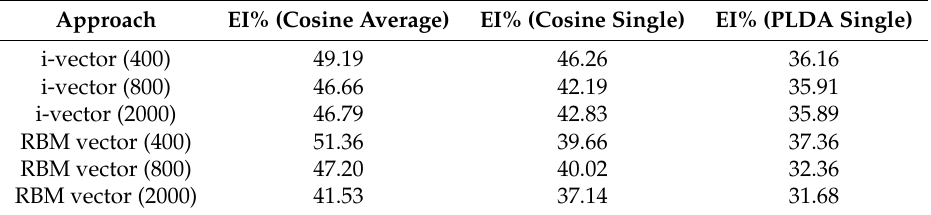
Table 1. Comparison of speaker clustering results for the proposed RBM vectors with i-vectors, in terms of Equal Impurity (EI) in %. The dimensions of vectors are given in parenthesis. Each column shows EI in % for different scoring and linkage